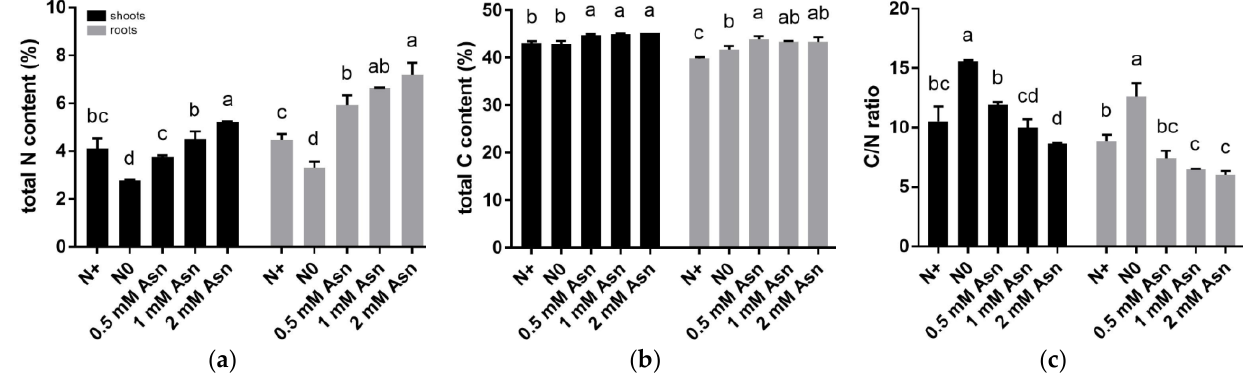
Figure 3. Effects of exogenous asparagine (Asn) on the nitrogen (N) and carbon (C) contents in the shoots and roots of poplar ‘Nanlin895’. ( a ) total N content; ( b ) total C content; ( c ) the C/N ratio. “N0” indicates N-free reference; “N+” represents the inorganic N control. The concentration of Asn applied was 0.5 mM, 1 mM, and 2 mM as indicated. Bars denote means ± SD (n ≥ 3), and different letters indicate significant differences ( p < 0.05) based on Duncan’s test.